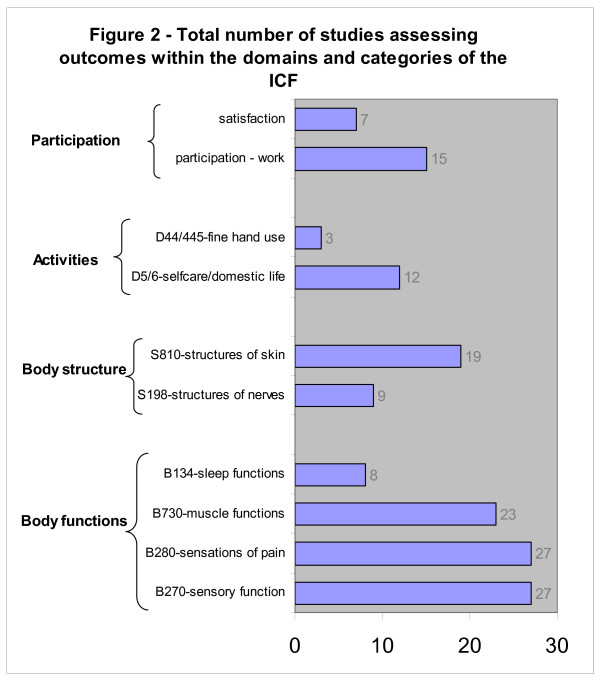
Total number of studies assessing outcome within the domains and categories of the ICF.